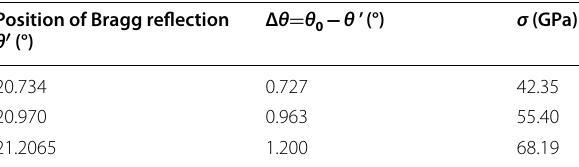
Table 2 Values of σ calculated according to the X-ray diffraction data Position of Bragg reflection θ ′